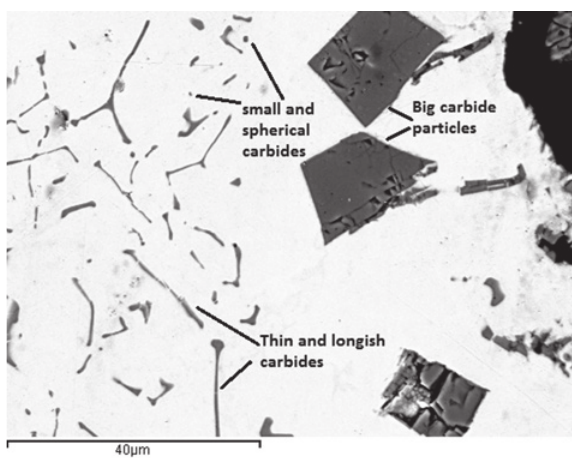
Fig. 15: SEM-BSE image of the alloy droplet in experiment 6 (Fe-TiCMo